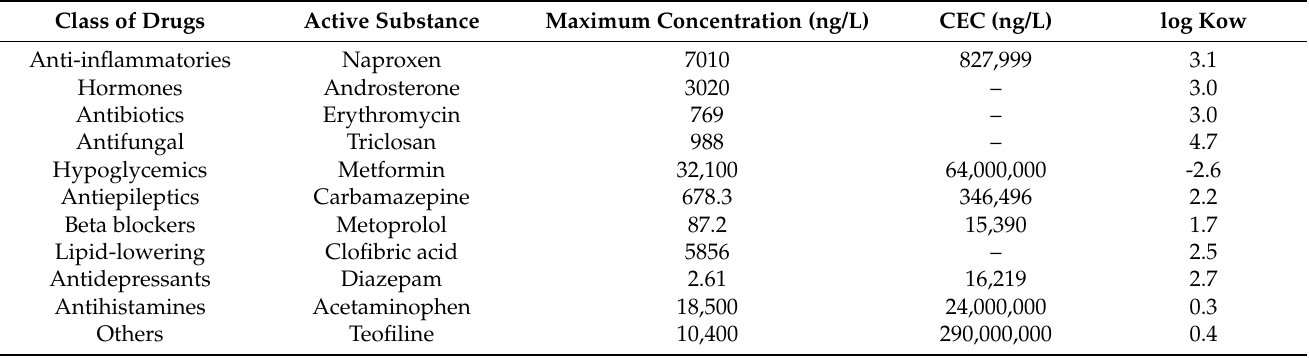
Table 3. Characteristics of the active substances registered for Mexico City associated with ecological